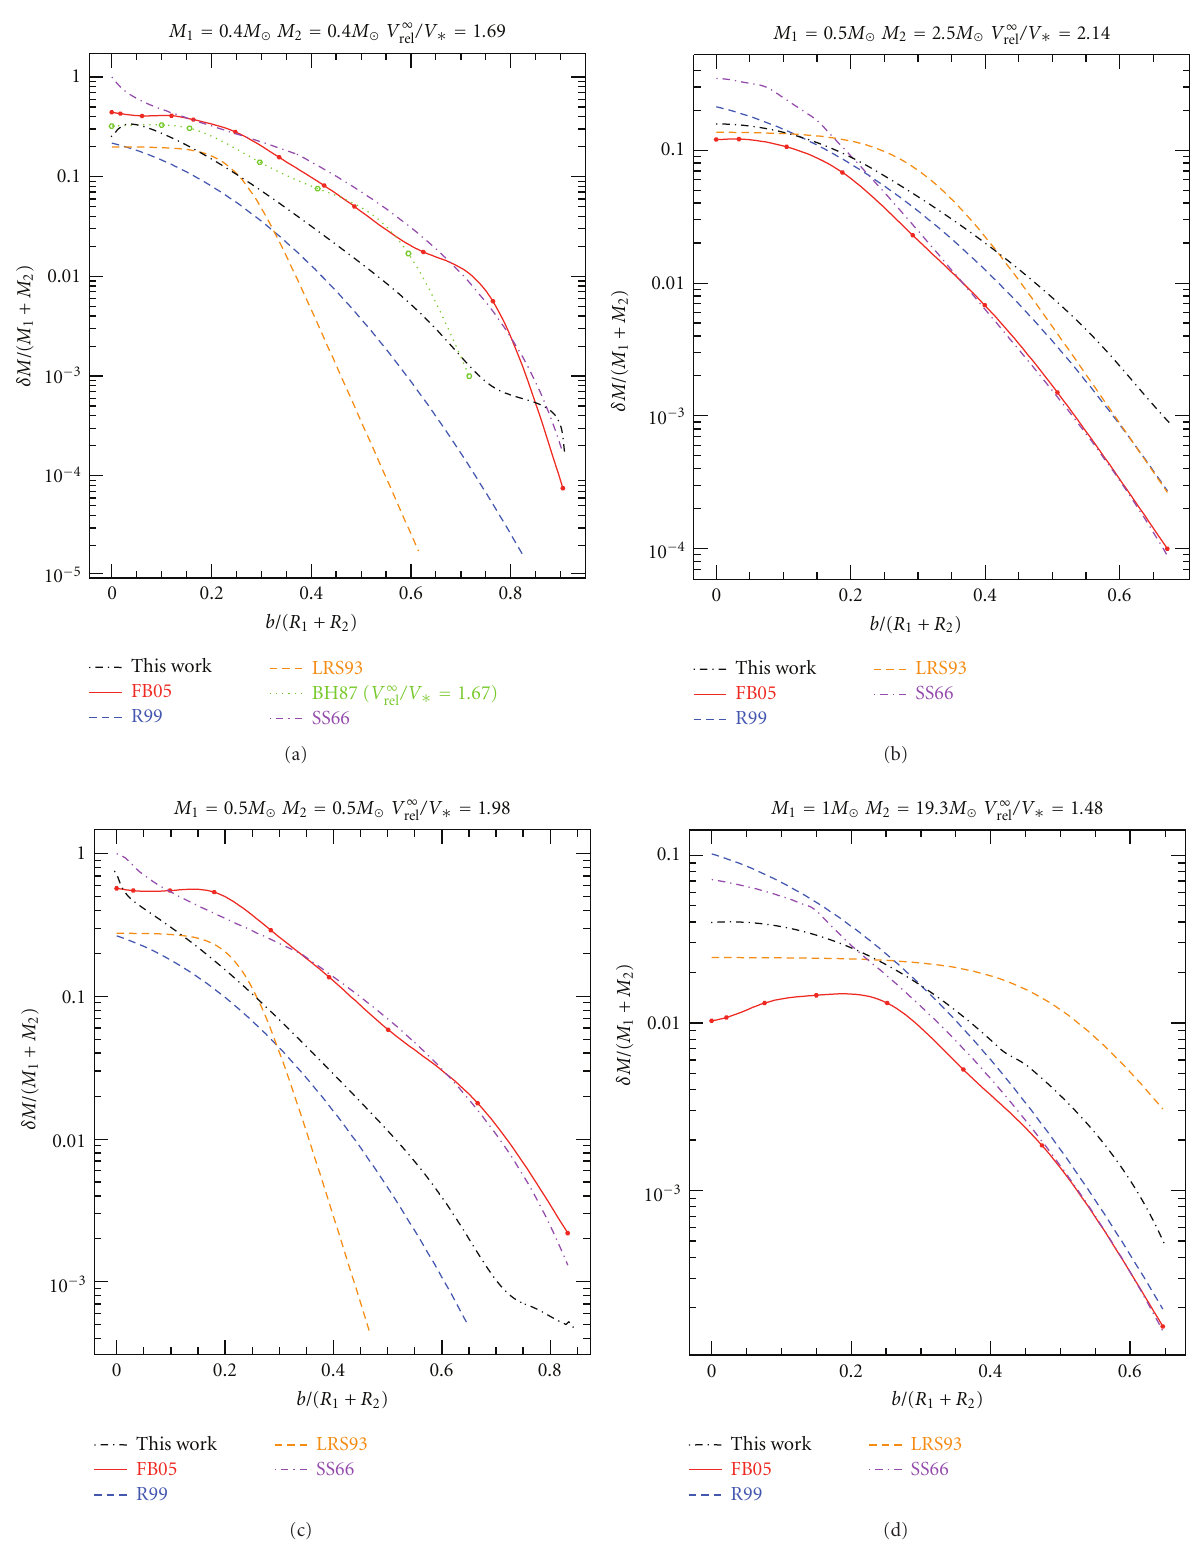
Figure 5: The calculated fractional amount of mass lost as a function of impact parameter from several works. Our results are the black dashed-dotted lines. The acronyms FB05, R99, LRS93, BH87, and SS66 refer to Freitag and Benz [38], Rauch [33], Lai et al. [32], Benz and Hills [30], and Spitzer and Saslaw [40], respectively. The figures are adopted from Freitag and Benz